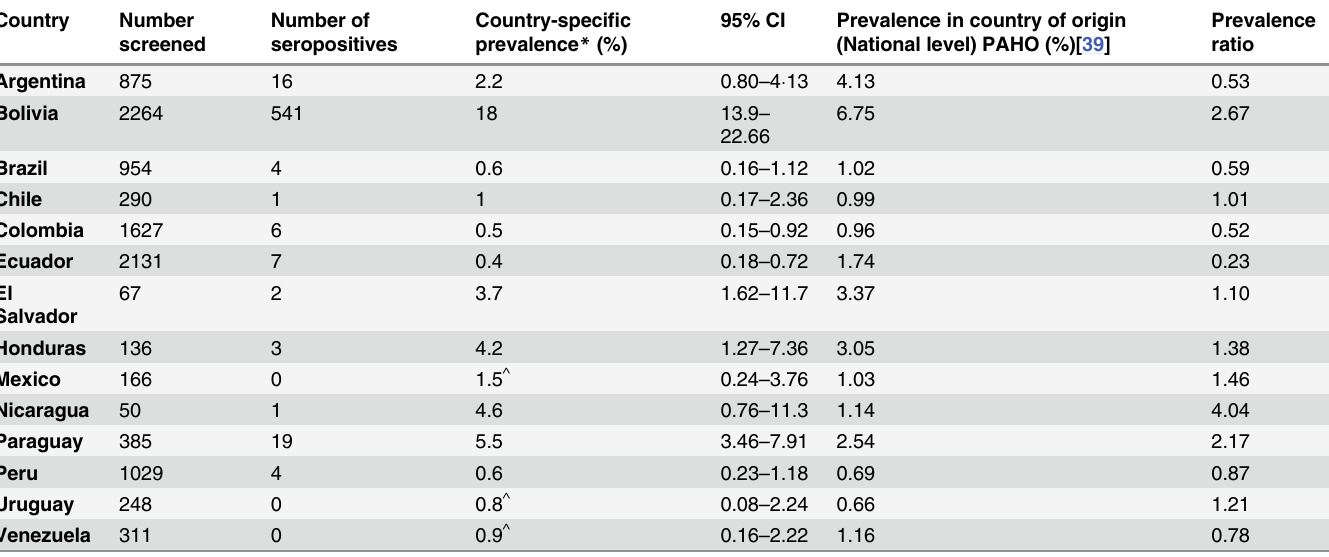
Table 4. Pooled T. cruzi prevalence by country of origin in Latin American migrants from European countries. Country Number